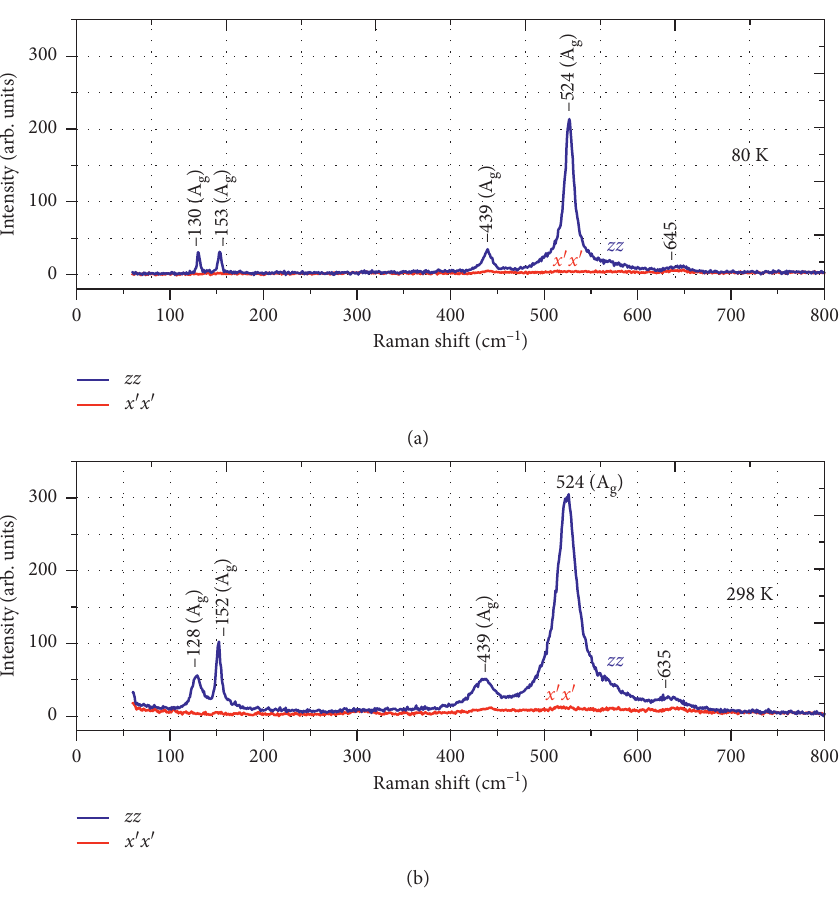
Figure 2: zz and x ′ x ′ polarization Raman spectra of (110)-oriented PBCO thin films.